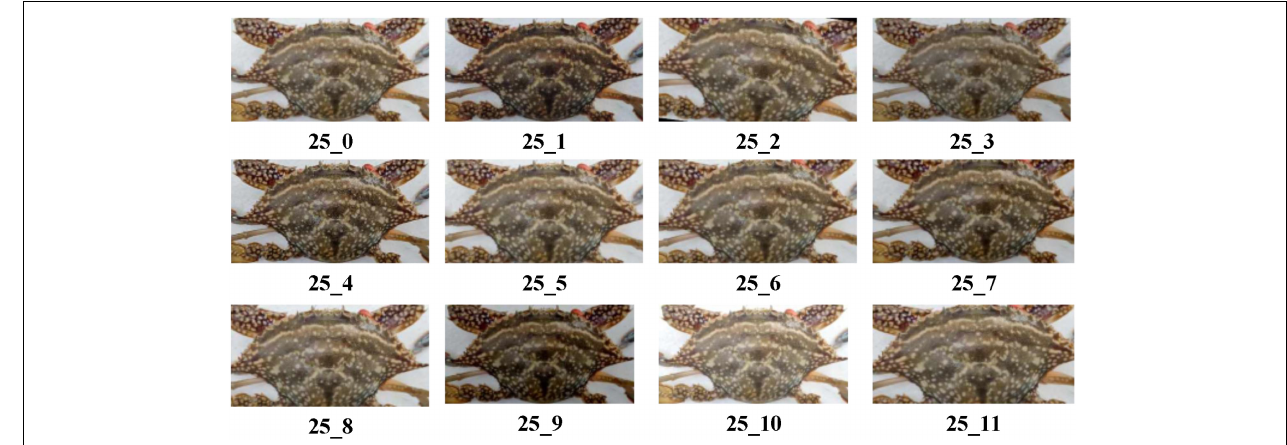
FIGURE 1 | Pictures of different scenes of Portunus trituberculatus